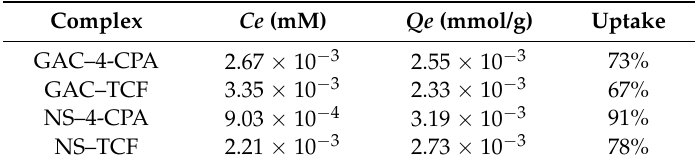
Table 5. Ce and Qe values obtained for two sorbents: nanosponges (NS) and granular activated carbon